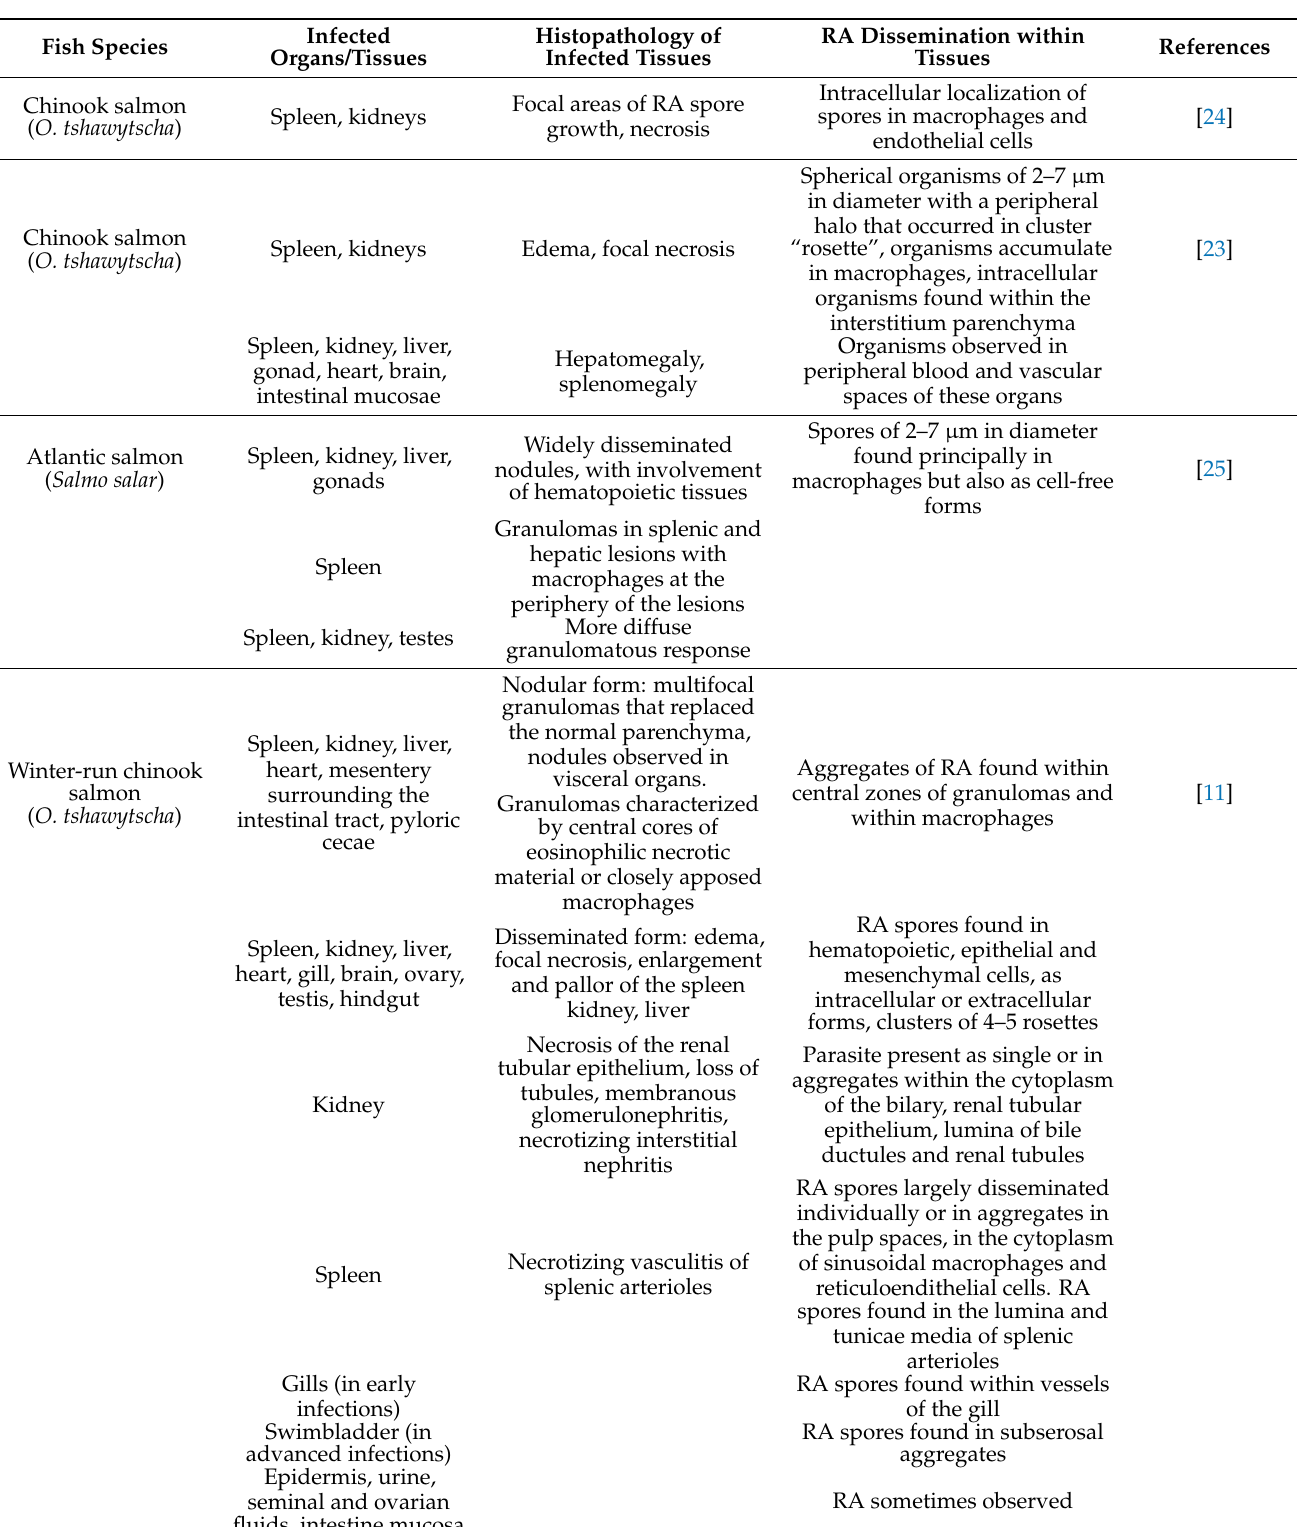
Table 1. Description of organ and tissue types infected with RA, the histopathological features of the disease, as well as RA spore dissemination within